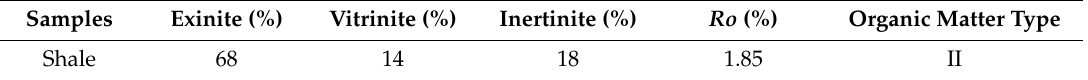
Table 2. Geochemical characteristics of the shale samples [24].